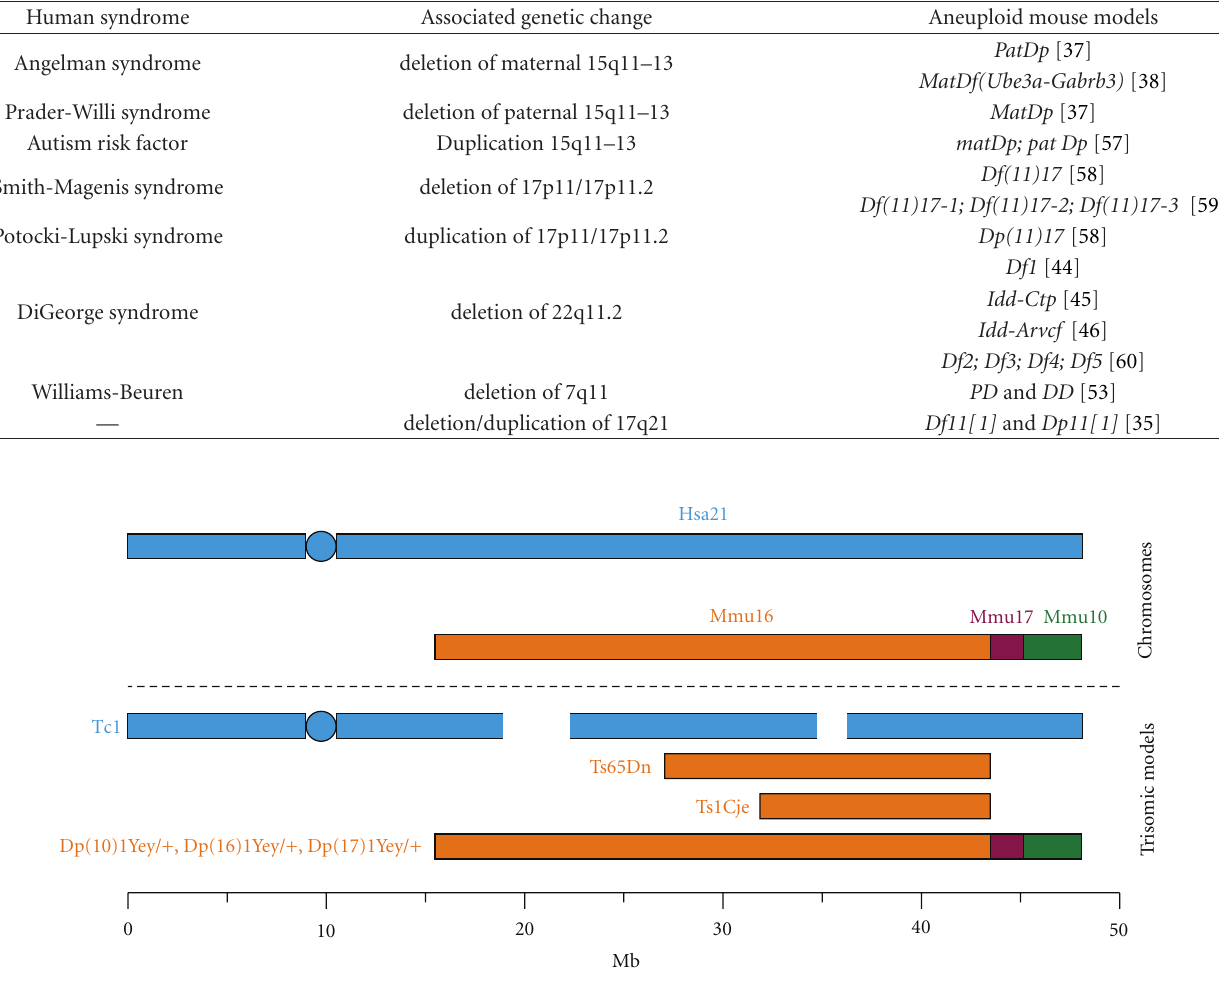
Figure 1: Mouse models of Down syndrome. Hsa21 (in blue) and the syntenic mouse chromosomes (Mmu 16, orange, Mmu 17, purple, Mmu10, green). The trisomic regions of several of the well-established mouse models of DS, the Tc1 mouse, Ts65Dn, Ts1Cje, and Dp(10)1Yey/+, Dp(16)1Yey/+, Dp(17)1Yey/+ are aligned to the corresponding parts of the human and mouse